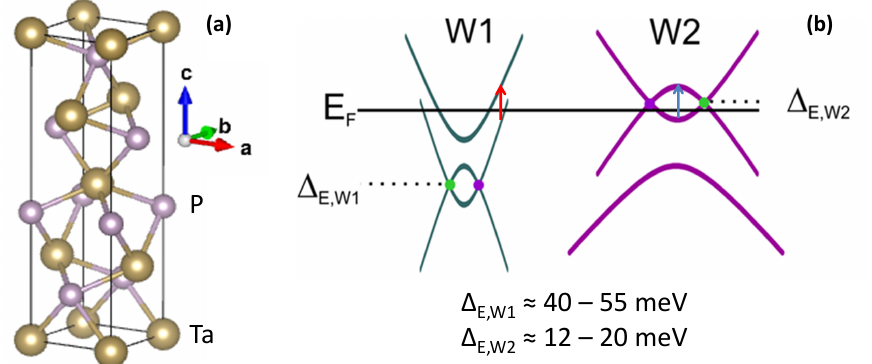
Figure 1. ( a ) Crystallographic structure of TaP and ( b ) a schematic diagram of its Weyl bands. Possible transitions between the saddle points of the merging Weyl bands and between the SOC-split bands are indicated as